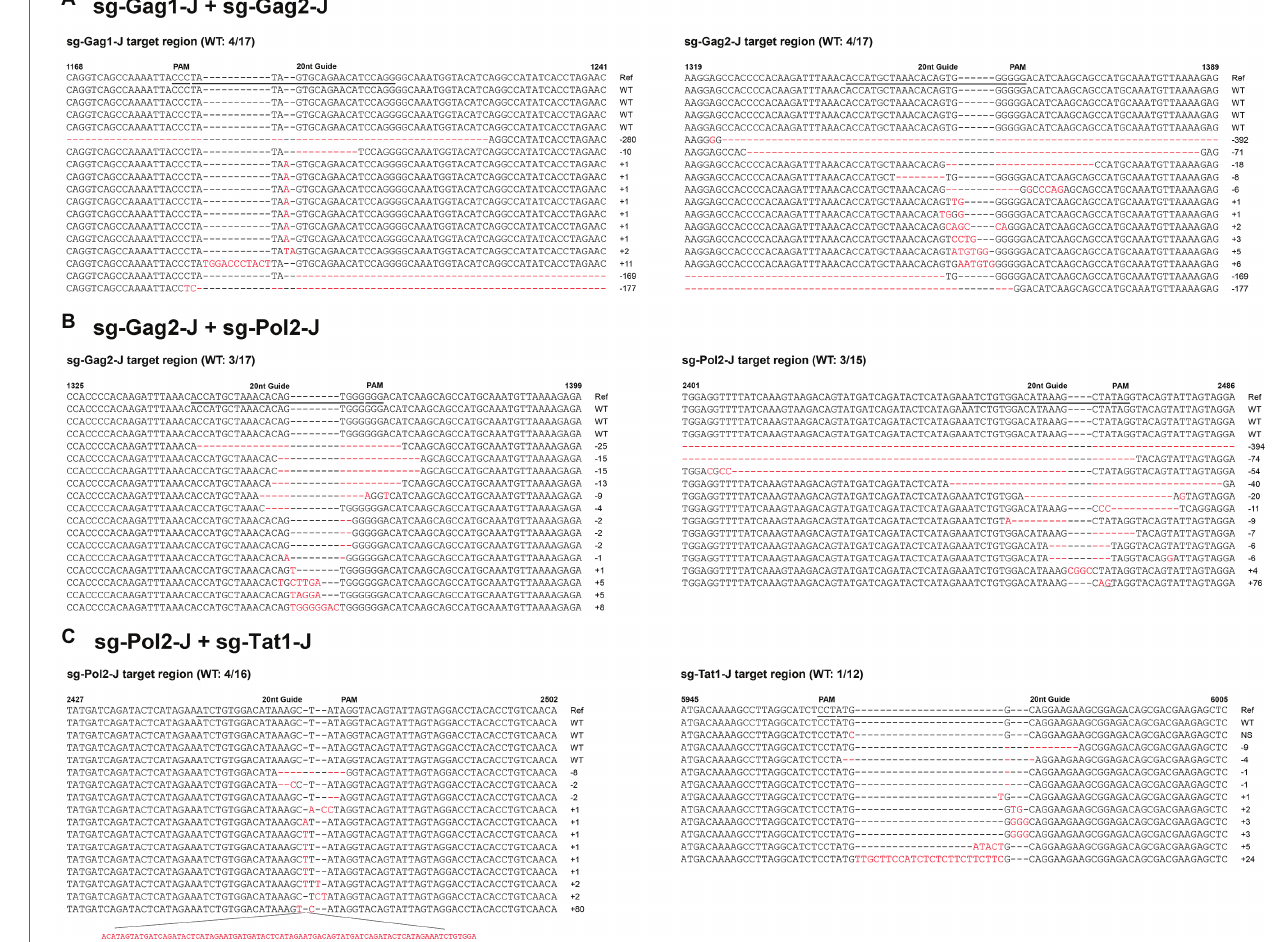
FIGURE 4 | Sequence analysis of HIV-1 mutation sites in dual-sgRNAs/Cas9-treated J-Lat 10.6 cells. Features of the mutations in the three most efficient dual- sgRNA combinations: (A) sg-Gag1-J + sg-Gag2-J. (B) sg-Gag2-J + sg-Pol2-J. (C) sg-Pol2-J + sg-Tat1-J. All sequences were aligned with the reference strain HXB2. The 20 nt guide sequence and the protospacer adjacent motif (PAM) sequence are underlined. The sequences of nucleotide substitutions, insertions, and deletions are indicated using red letters. Ref, reference sequence; − x/+x, x nt deleted/inserted; NS, nucleotide substitution; and WT, wild-type